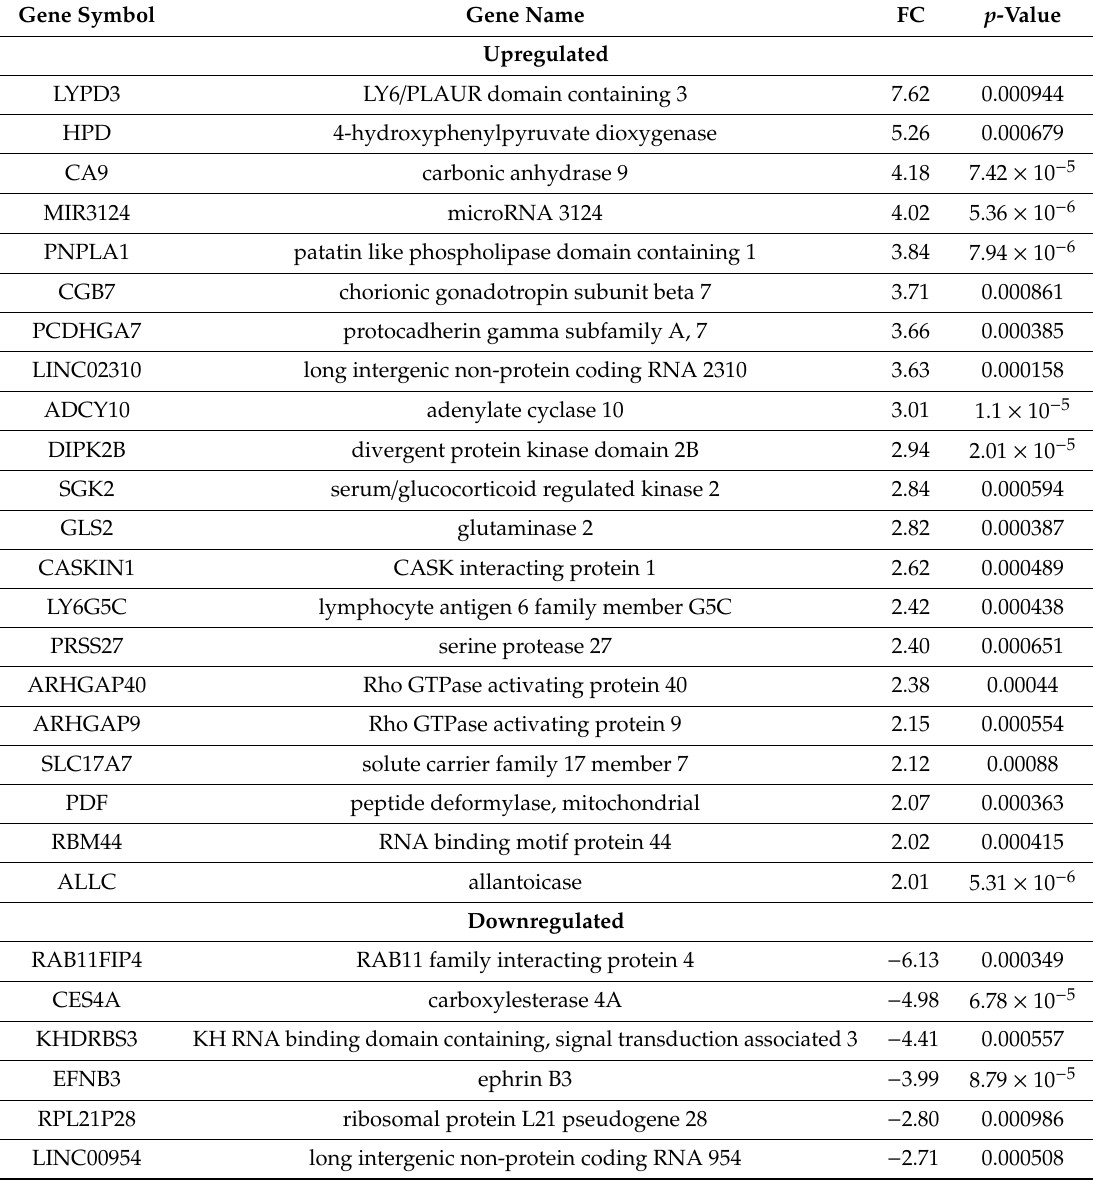
Table 1. Di ff erentially expressed genes in rhGM-CSF-stimulated BEC vs. untreated control cells. Gene Symbol Gene Name p